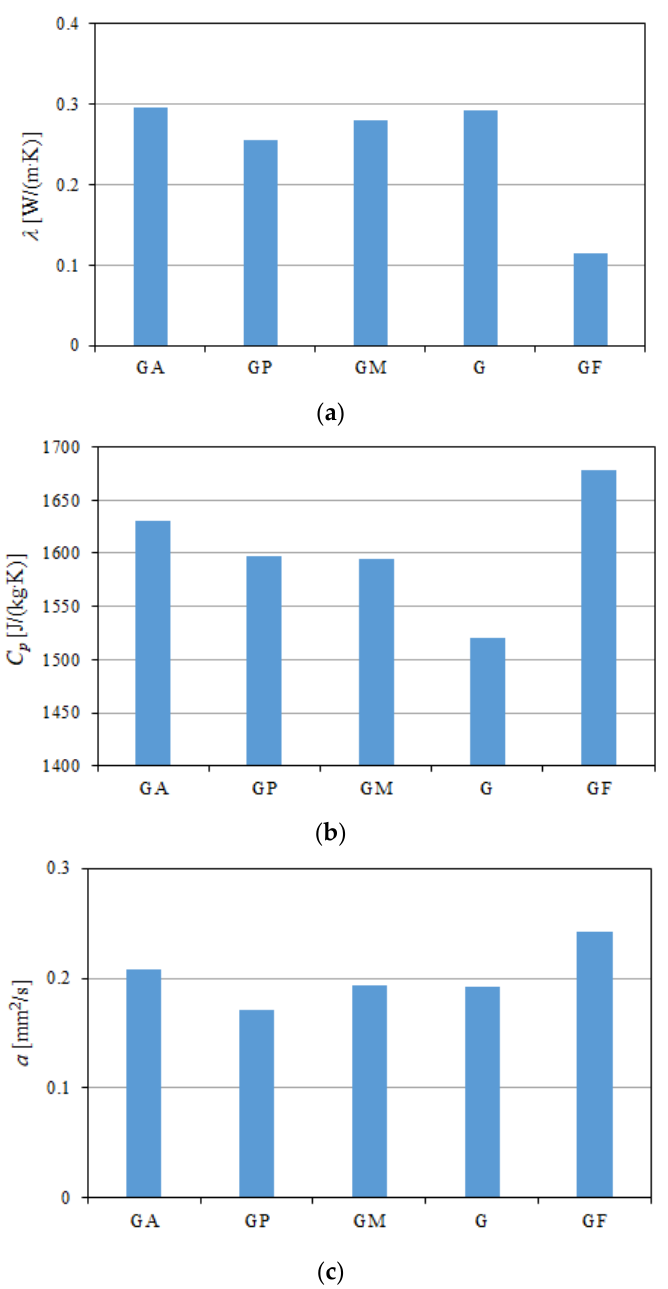
Figure 4. The obtained average values of ( a ) thermal conductivity, ( b ) specific heat, and ( c ) thermal diffusivity of modified gypsum samples and geopolymer.